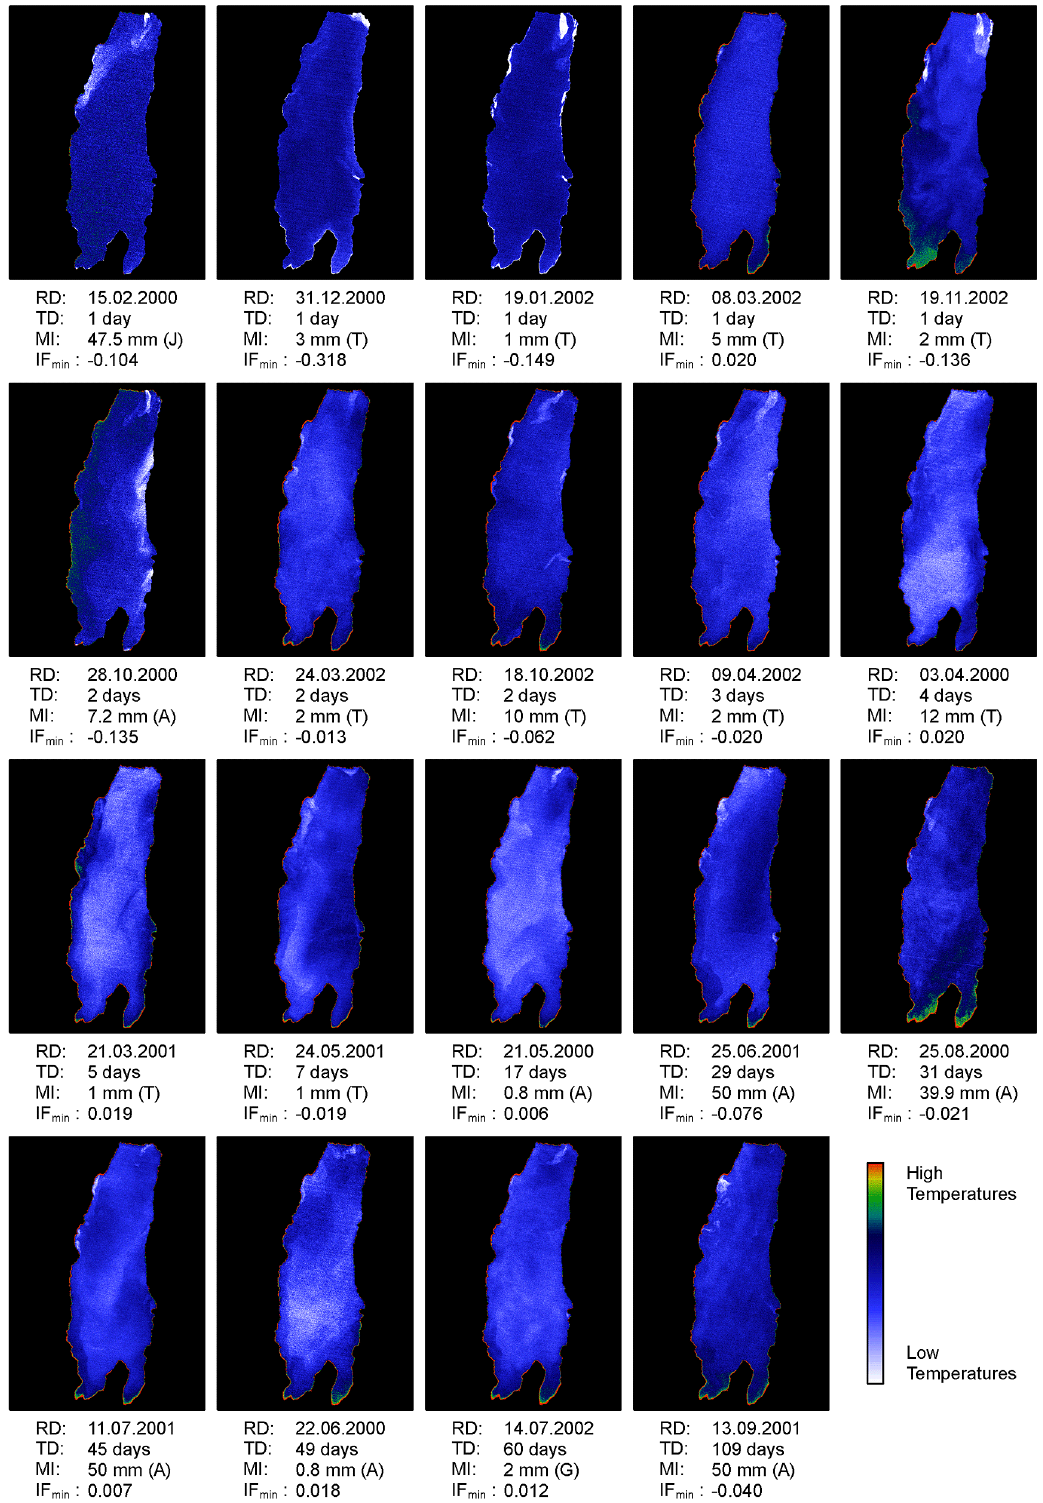
Figure 2. Overview of available SST data for 2000 to 2002, sorted according to the time difference from the last rain occurrence (data show real temperatures and are individually scaled to enhance the contrast). RD: date of image recording; TD: time difference from the end of last rain even; MI: maximum intensity of rain for last rain event, the letter after MI describing rainfall station where the last rain event was recorded; J: Jerusalem; G: Gilgal; A: Amman; T: TRMM; IF min =minimum IF value